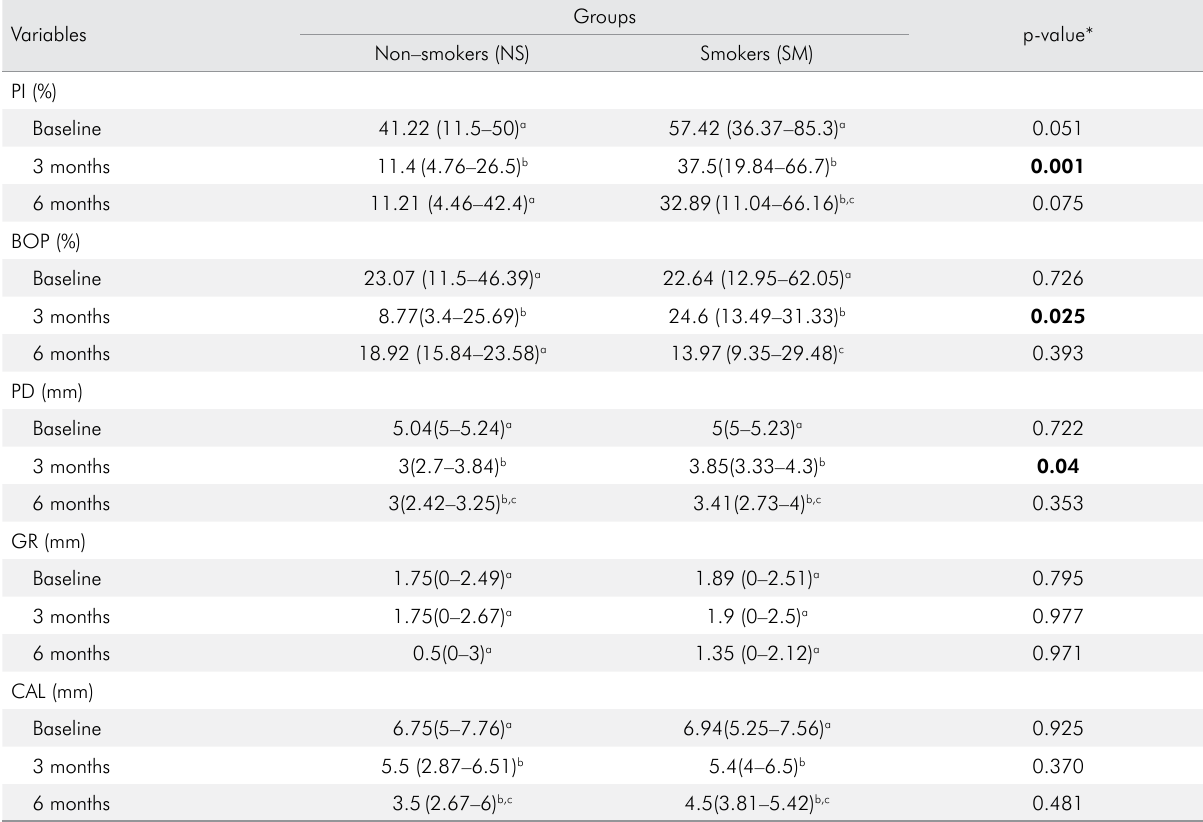
Table 1. Clinical evaluation of smokers in comparison with non-smokers at baseline and after 3 and 6 months of periodontal therapy. Values express in medians (percentile 25-percentile